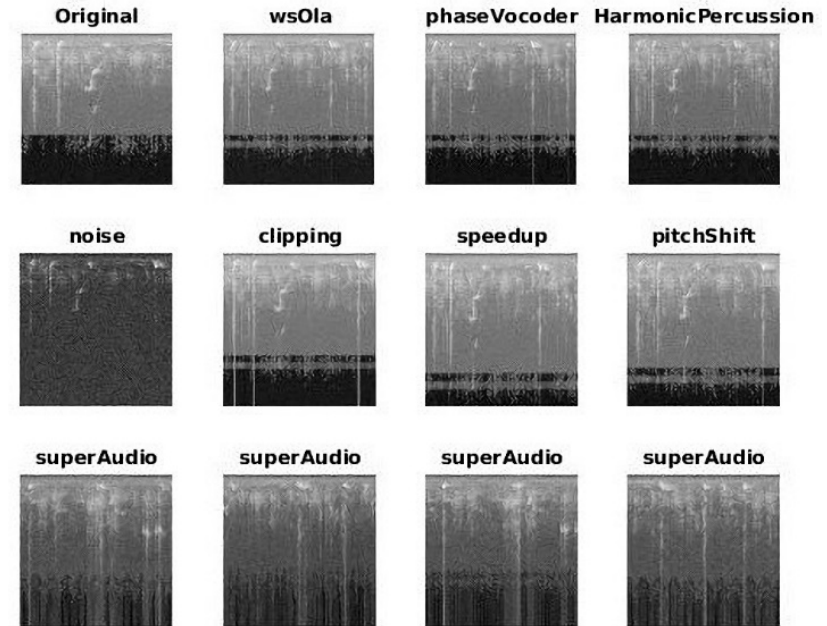
Figure 2. Audio augmented samples, where the last row shows the iterative applications of multiple random augmentations (SGN, SSA, SSiA, and TSM). The horizontal axis in each image represents time, and the vertical axis represents frequency.